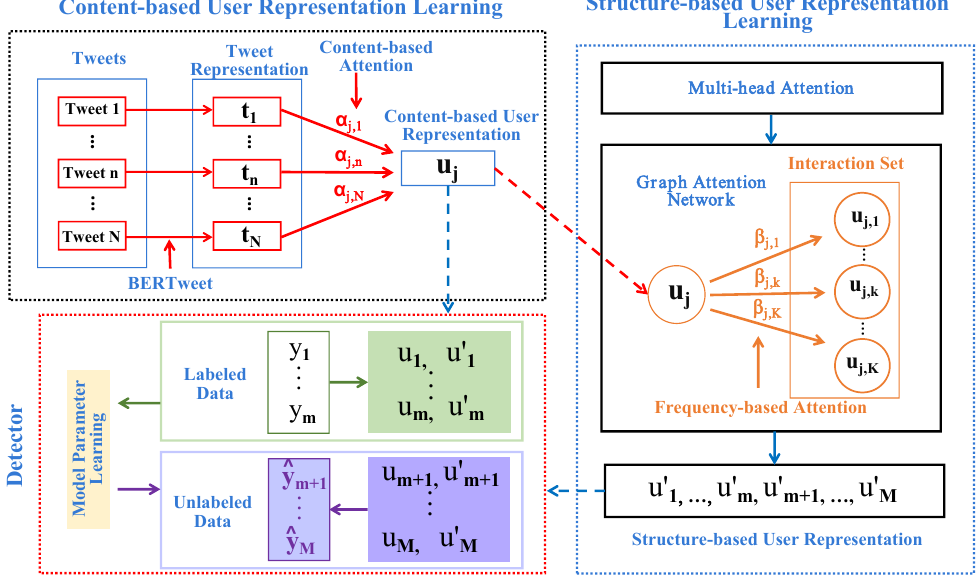
Figure 4. Overview of the proposed ASpamDetector , which contains three key components: content- based user representation learning, structure-based user representation learning, and